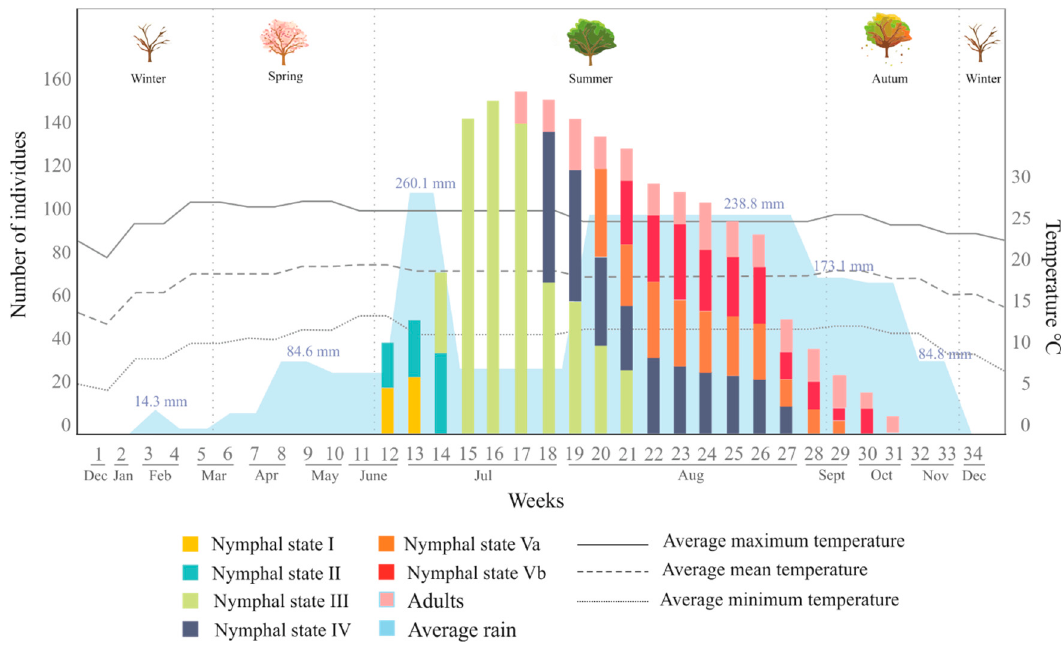
Figure 10. The number of individuals of Ocoaxo assimilis collected from December 2017 to December 2018, in Nicolas Bravo, Puebla, corresponding to nymphal and adult stages. Abundances per stages are presented in the color bars; the average monthly rainfall is shown along the bottom in blue; the average monthly temperatures (mean, maximum, and minimum) correspond to the bottom lines.